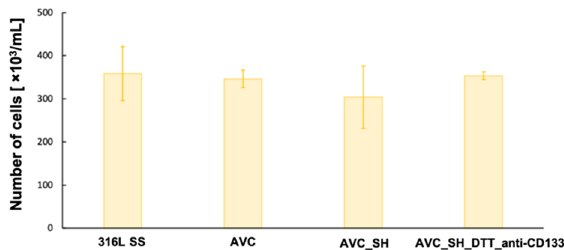
Figure 10. Macrophages concentration after 48 h incubation on the functionalized surface with AVC, with AVC after mercaptosilanization and with AVC after mercaptosilanization, reduction and anti-CD133 immobilization.